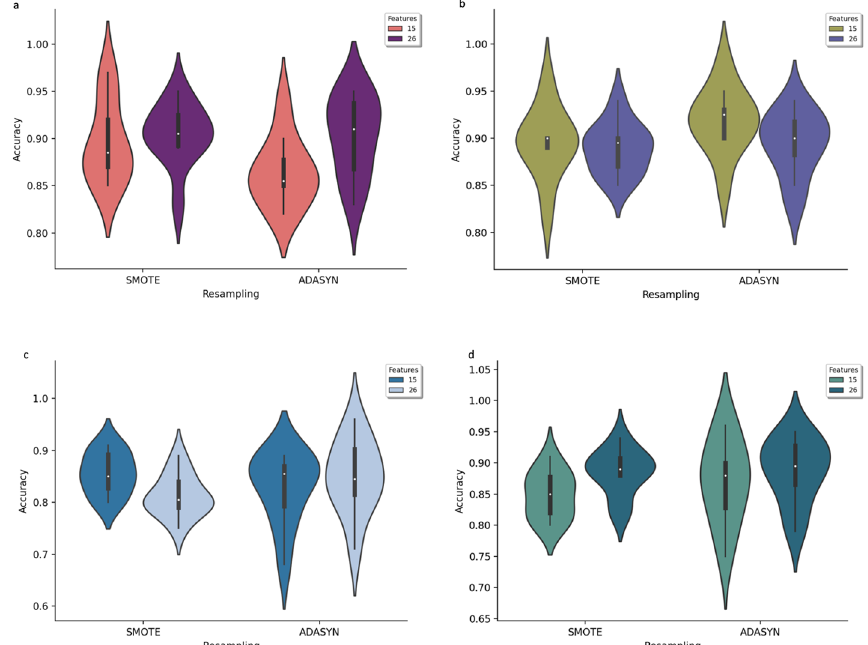
Fig. 3 Violin plots showing the distribution of accuracy estimates obtained across the cross‑validation folds during model training of four algorithms using two synthetic class imbalance correction methods—( a ) gradient boosting ( b ) k‑nearest neighbor ( c ) multilayer perceptron ( d ) linear discriminant